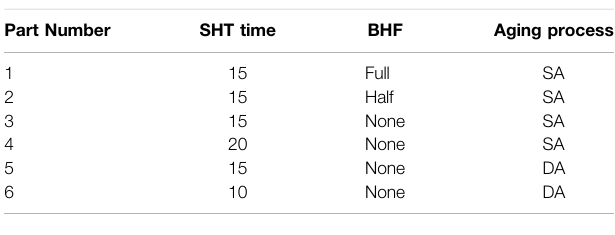
TABLE 1 | The designed experiment conditions.